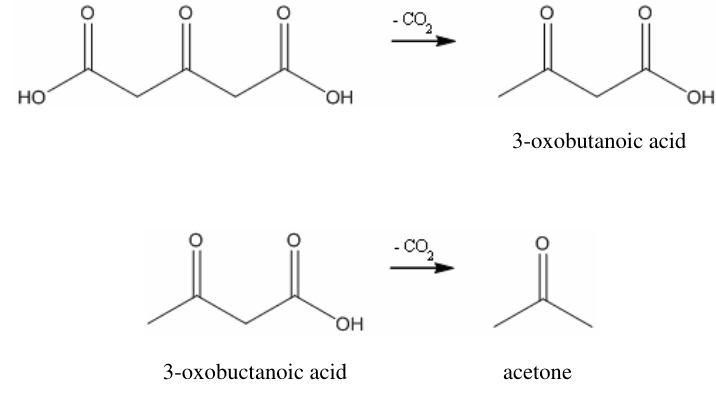
Fig. 6. The two steps in the decarboxylation of 3-oxoglutaric